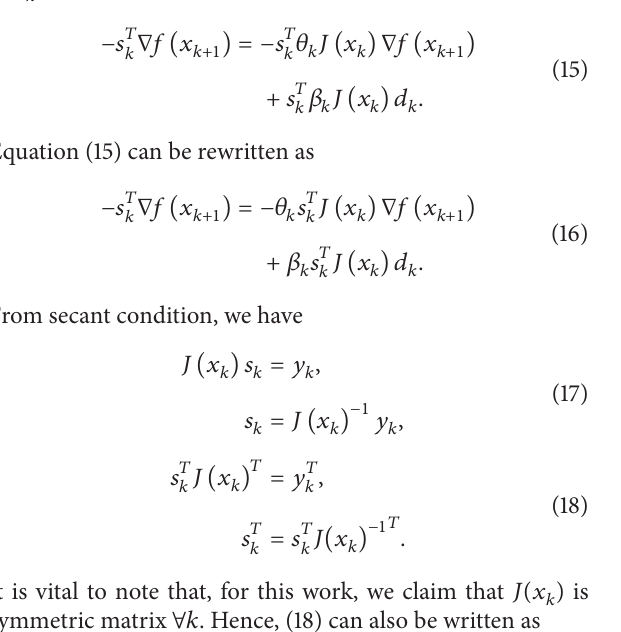
Algorithm 1 (derivative-free CG method (DFCG)). Consider the following